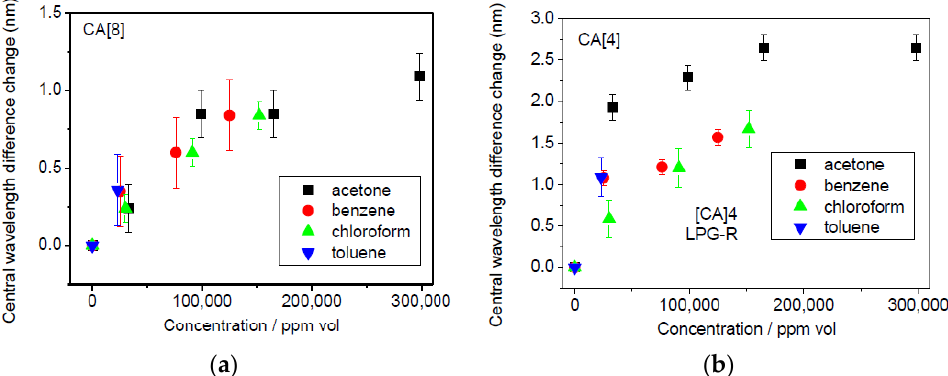
Figure 10. ( a ) CA[8] and ( b ) CA[4] Sensor’s response related to towards selected VOCs at different concentration levels (the error bars represent the standard deviation).